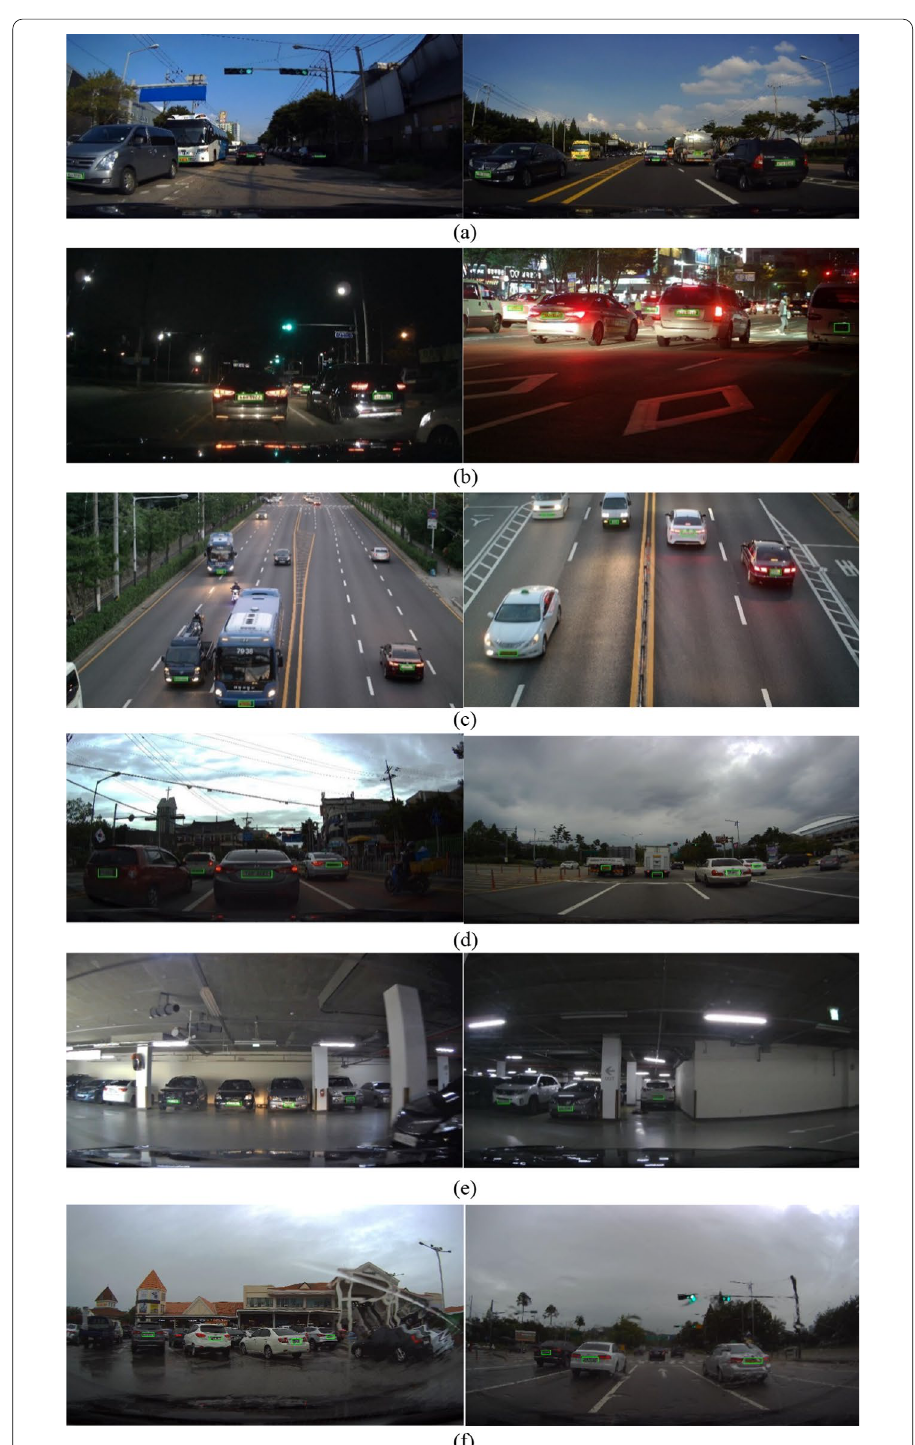
Fig. 10 Results of images taken: a sunny day, b night time, c dusk, d cloudy, e underground parking, and f